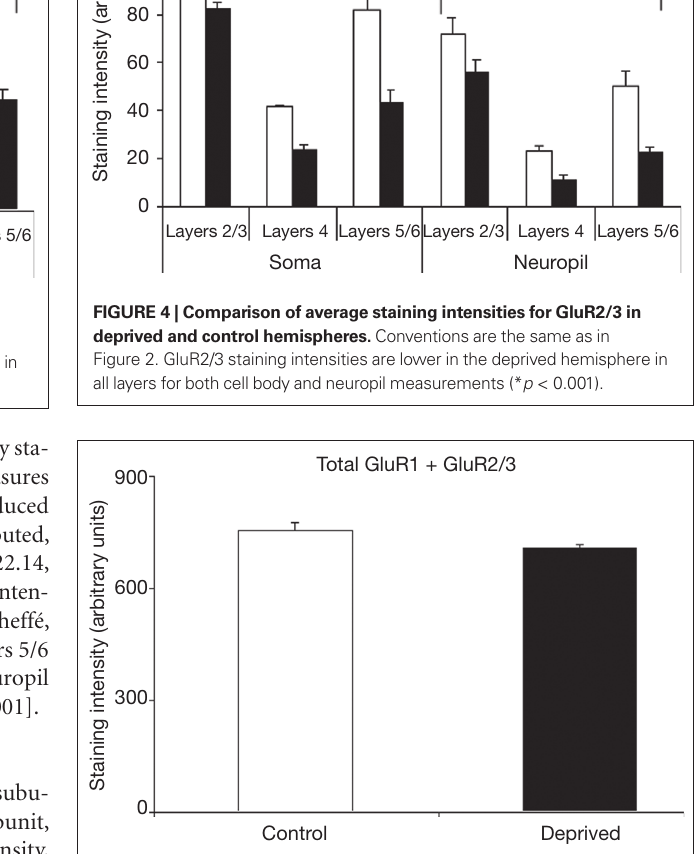
FIGURE 5 | Average total staining intensities for GluR1 and GluR2/3 in control and deprived hemispheres are comparable. This fi gure illustrates that while there are subunit differences in the deprived hemisphere, the summation of these measures indicates a relatively stable total level of combined GluR1 and GluR2/3 expression throughout control and deprived